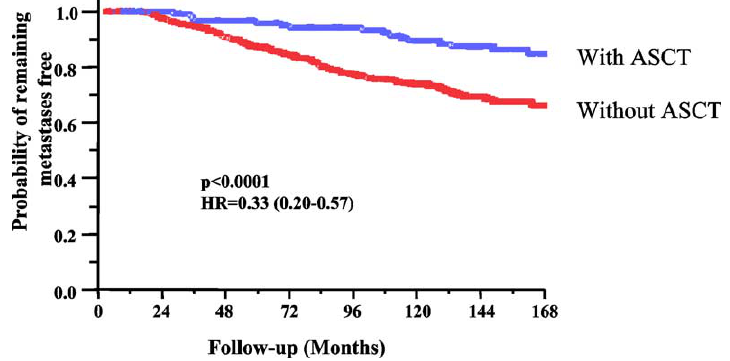
Fig. 1. Survival curves of node negative invasive breast cancer patients < 55 years, with and without adjuvant